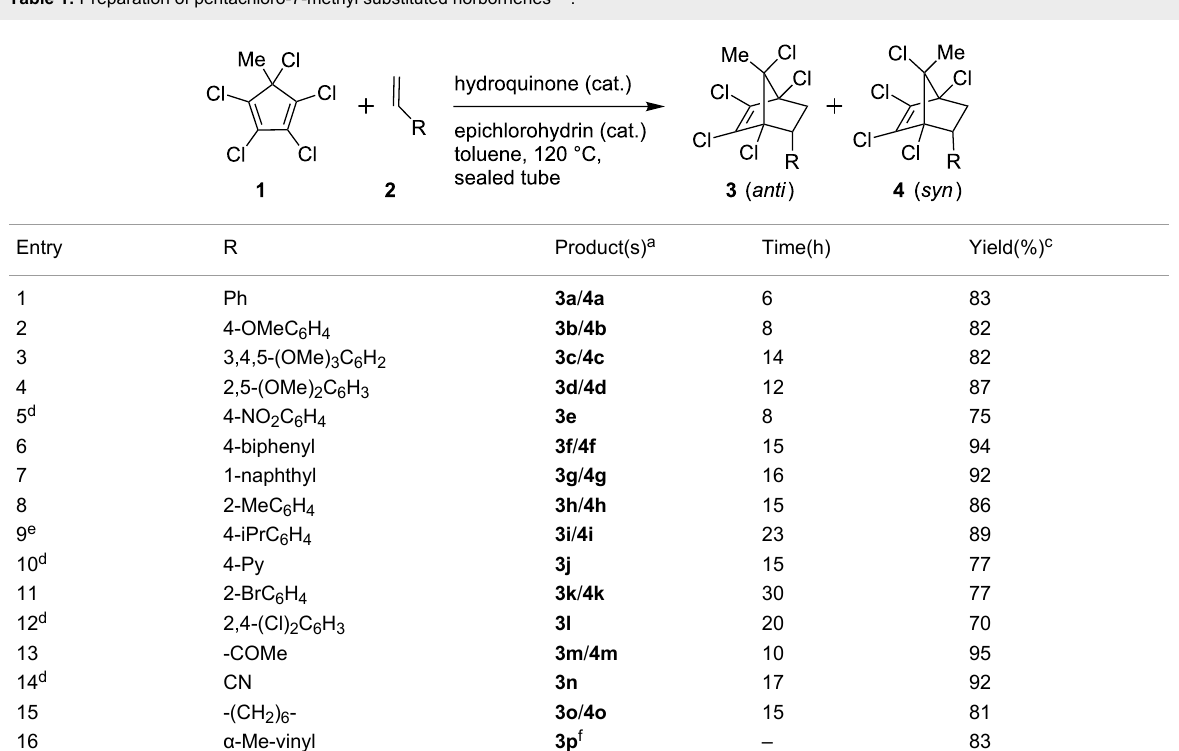
Table 1: Preparation of pentachloro-7-methyl substituted norbornenes a,b .